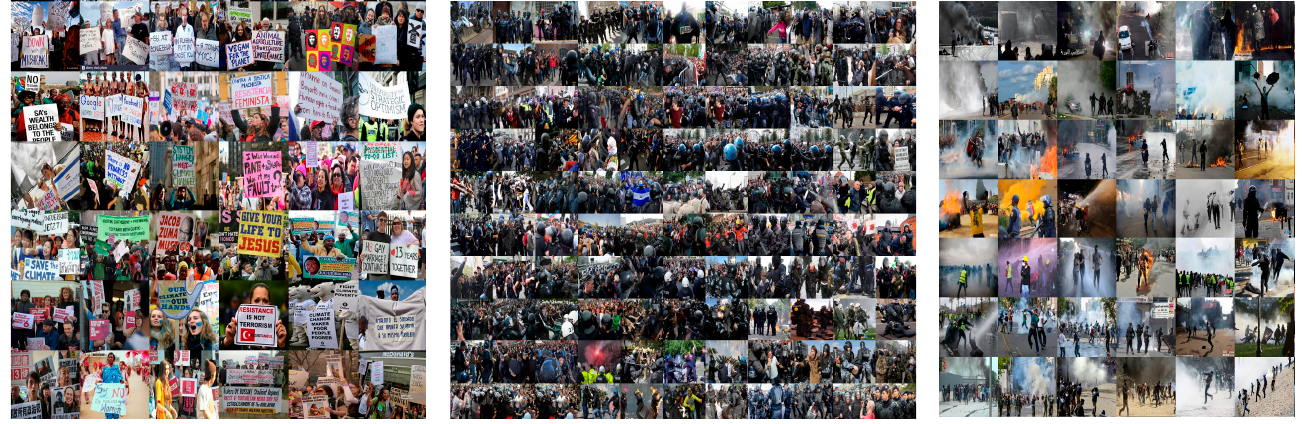
Figure 8. Examples of images belonging to Clusters 2, 1, and 7.